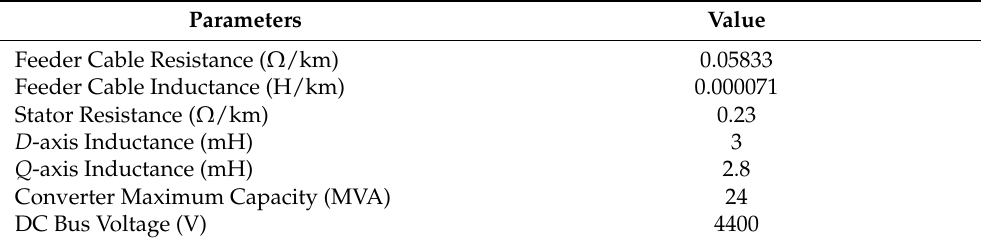
Table 2. The parameters of the LLSM and power supply system.